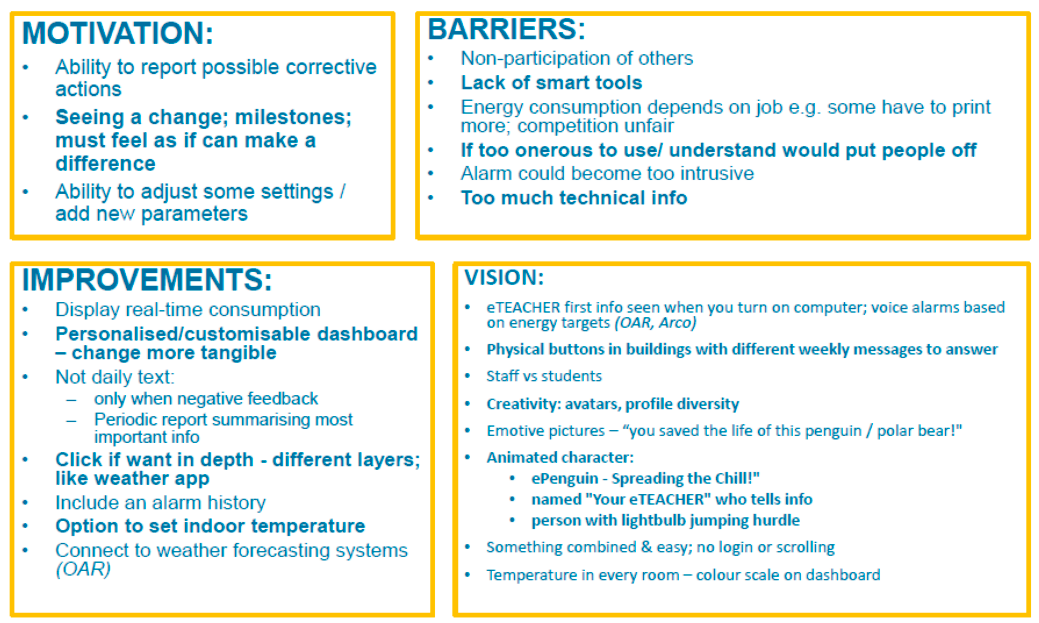
Figure 4. Smartphone usage by building user role.